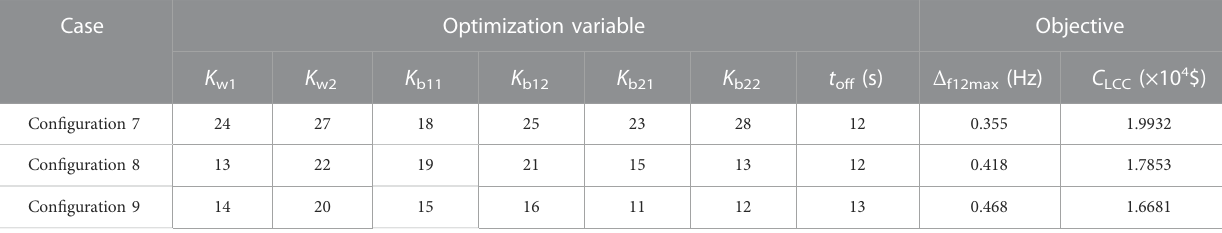
TABLE 6 Optimization results considering